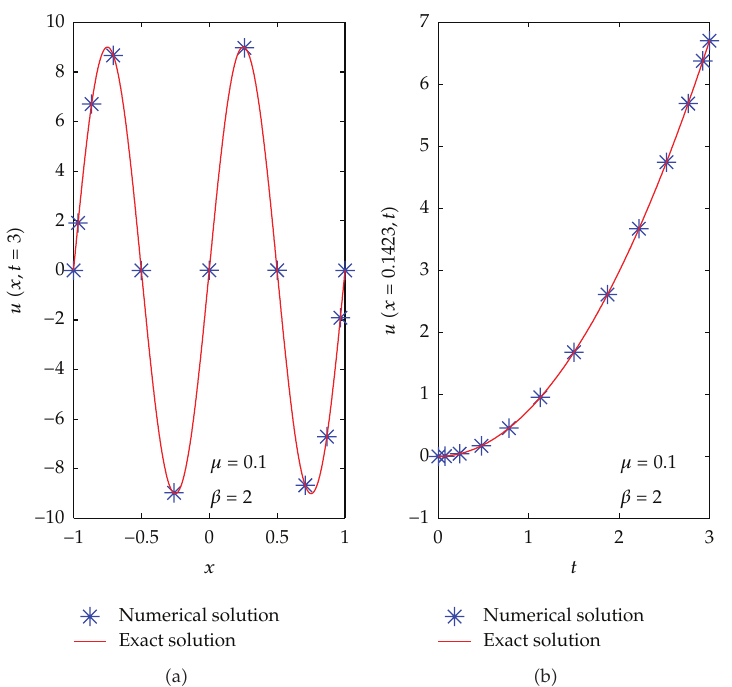
Figure 3: (cid:4) a (cid:5) The comparison of the exact solution and numerical solution when t (cid:6) 3. (cid:4) b (cid:5) The comparison of the exact solution and numerical solution when x (cid:6) 0 .